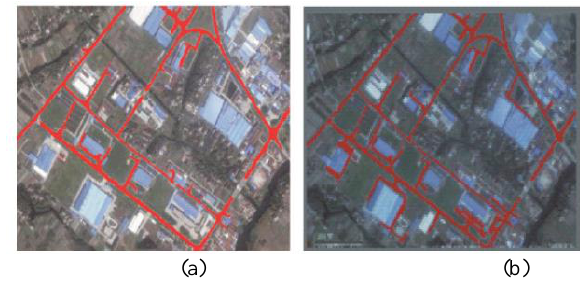
Figure 4. Two method for road extraction. (a) MRF-based detection. (b) SVM and FCM-based detection.